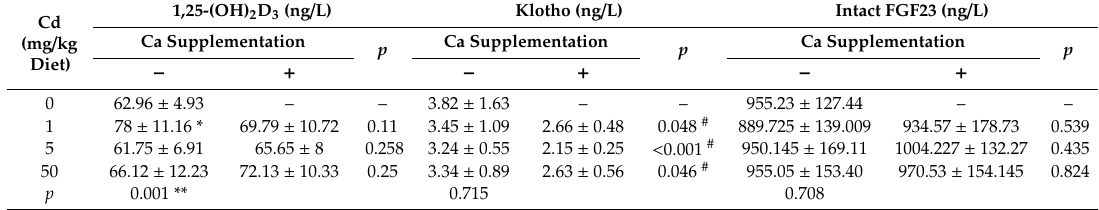
Table 12. Serum calciotropic hormones in the study of moderate Ca supplementation exposure to di ff erent diet Cd (Exp 2).